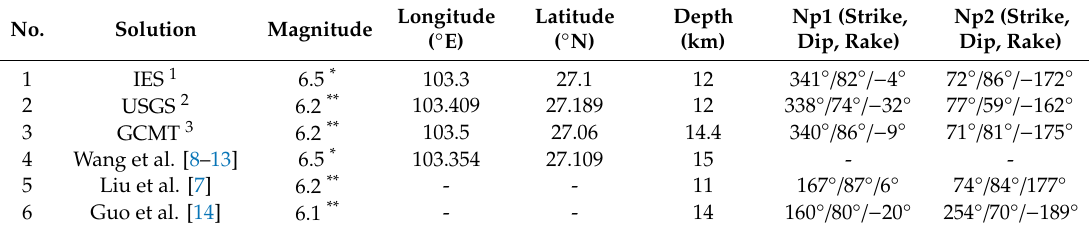
Table 1. Focal mechanism solutions for the 2014 Ludian